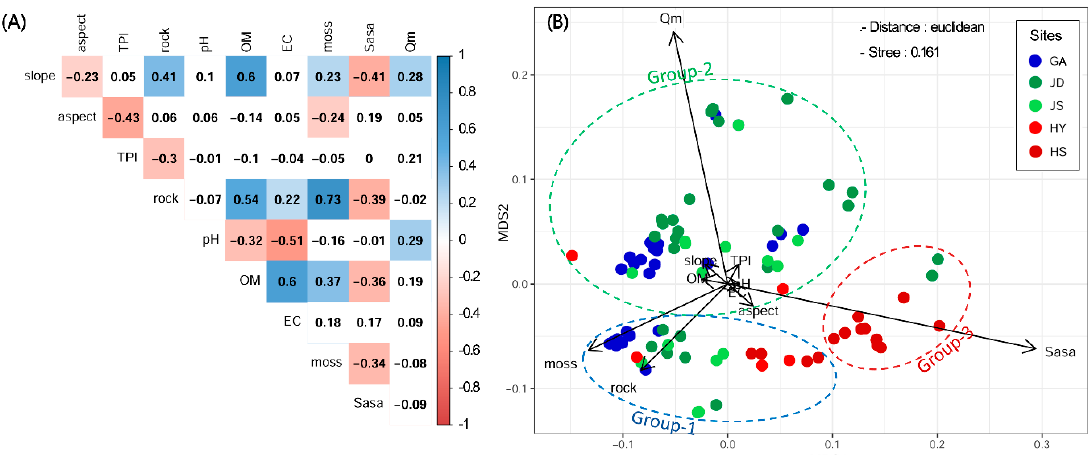
Figure 3. ( A ) A Pearson correlation coefficient plot of combinations of environmental variables (n = 84). Colored boxes represent a significant correlation coefficient between the variables ( p < 0.05); ( B ) The ordination of nonmetric multidimensional scaling (NMDS) based on the environmental variables matrix, showing the scores of the environmental variables. Dots represent individual plots sampled from the five sites. Dotted ellipses represent three groups based on hierarchical clustering of the NMDS points. GA: Mt. Gaya; JD: Dweajiryeong of Mt. Jiri; JS: Sesuck of Mt. Jiri; HY: Youngsil of Mt. Halla; HS: southern slope of Mt. Halla; TPI: topographic position index; OM: organic matter; EC: electrical conductivity; Qm: Quercus mongolica .